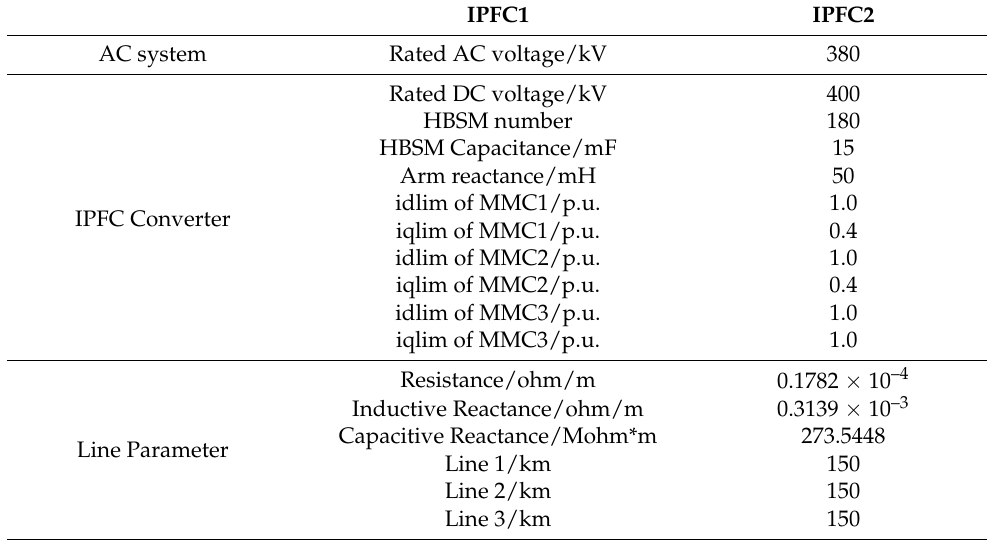
Table 2. System Parameters.